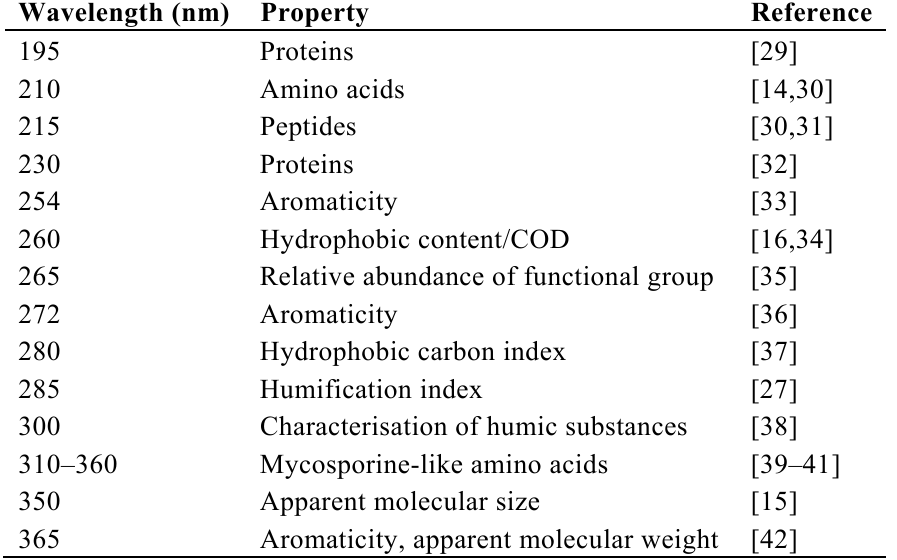
Table 3. UV absorbance recorded at various wavelengths used to measure chemical species in water and wastewater. COD = chemical oxygen